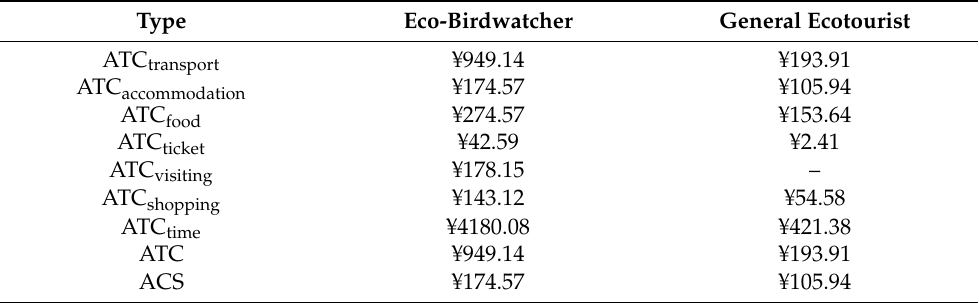
Table 4. Consumer surplus and travel cost per capita for general ecotourists and eco-birdwatchers.